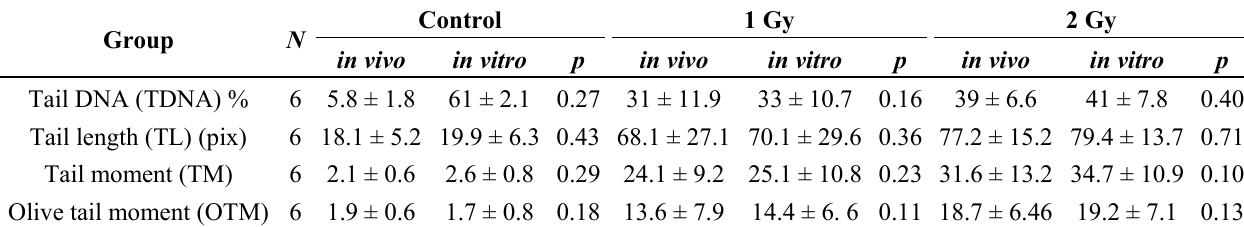
Table 1. Comparison between the in vivo and in vitro DNA double-strand breaks (DSBs) in mouse lymphocytes ( x ±